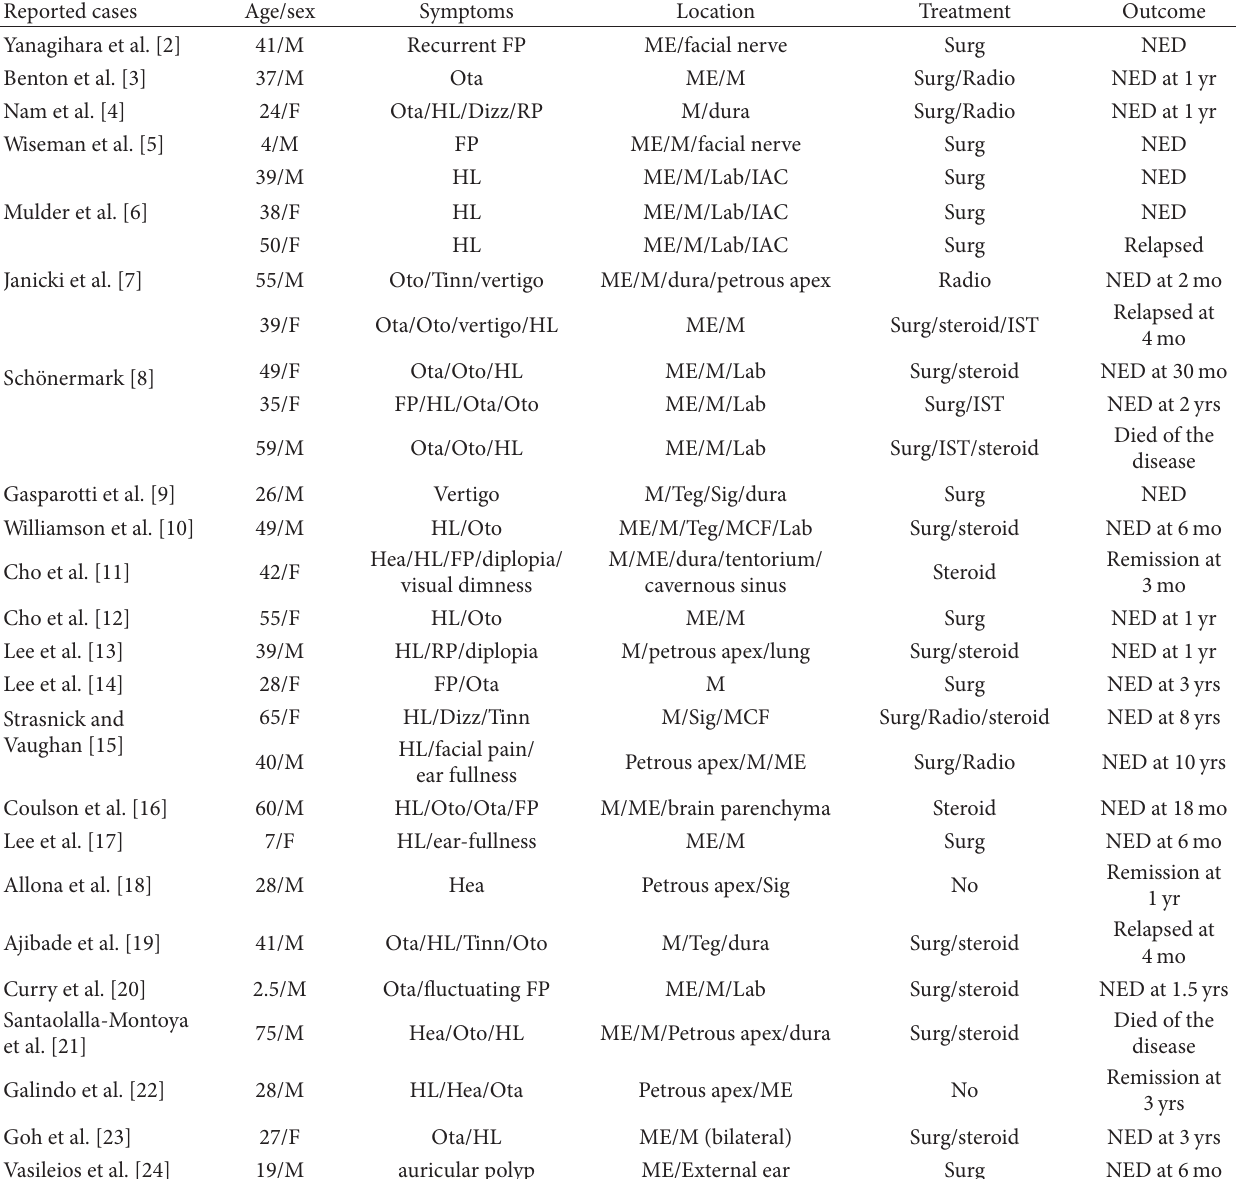
T 1: Clinical features of cases of temporal pseudotumor reported in the